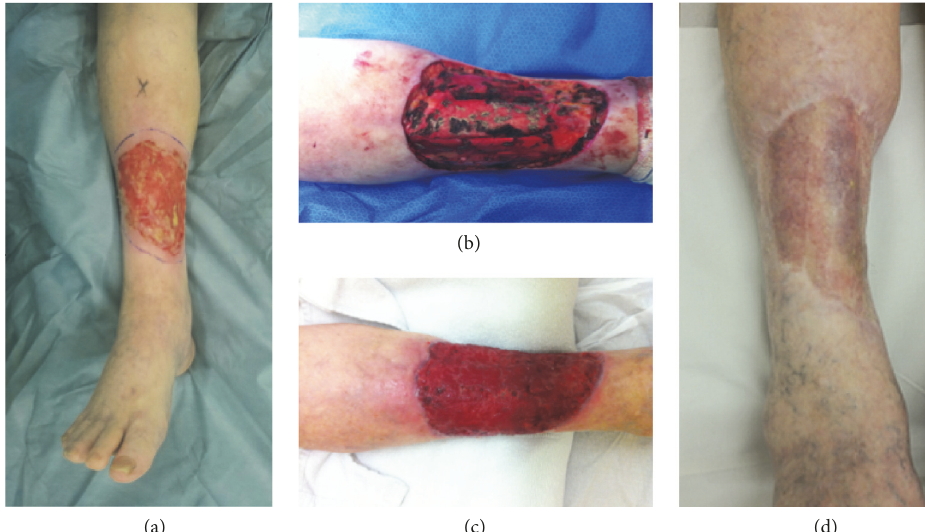
Figure 2: (a) Basal cell carcinoma in right leg, clinical aspect before surgery; (b) periosteal removal was necessary to ensure deep margins, which would not allow skin graft; (c) granulation tissue 28 days after Matriderm was placed (no negative pressure wound therapy was used in this case); (d) late postoperative